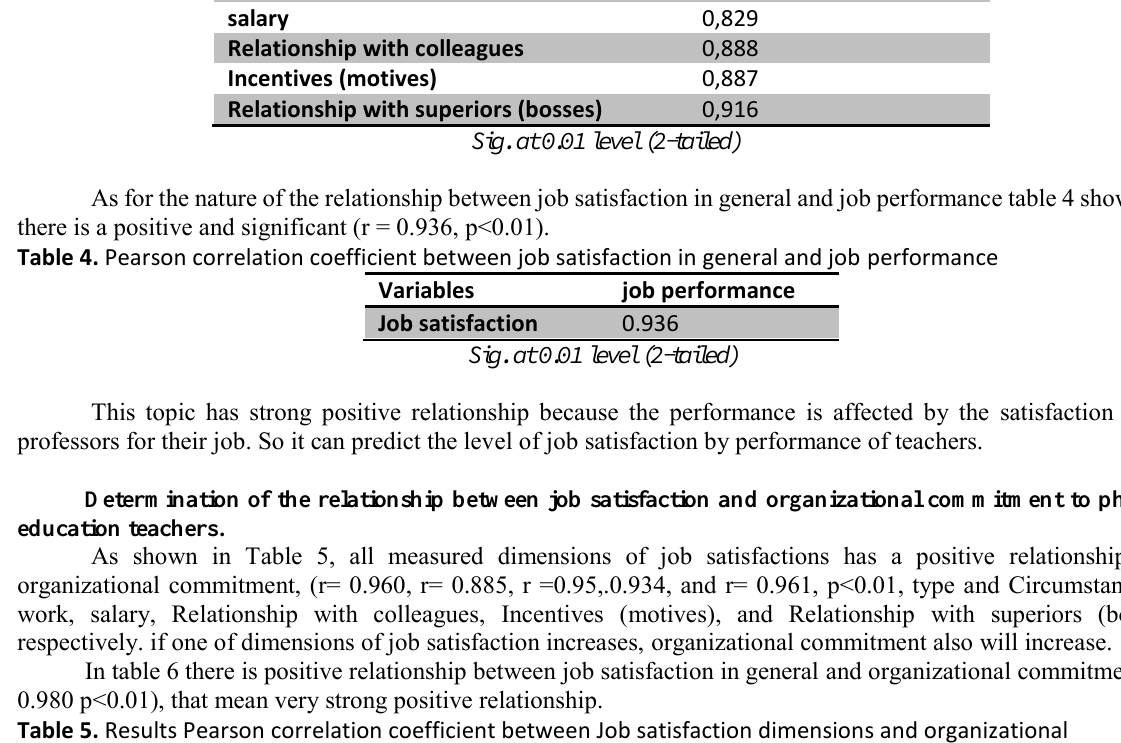
Table 3. Results Pearson correlation coefficient between Job satisfaction dimensions and job performance Job satisfaction dimensions job performance